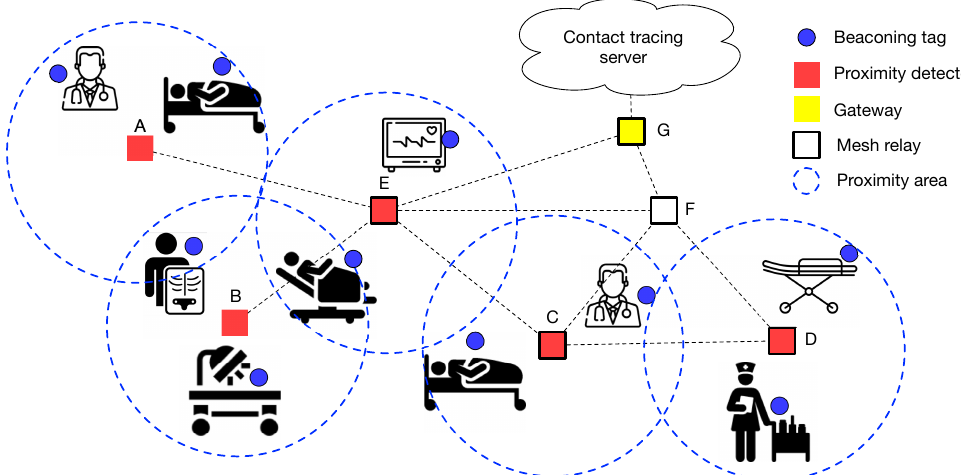
Figure 4. Bluetooth mesh infrastructure with the example topology. Beacons are identified with small colored circles. Nodes A and B are simple proximity detector, as they can read and process messages from beacons in their surrounding proximity area, which is limited by the dotted circles. Nodes C, D, and E behave as proximity detectors with respect to surrounding beacons, but also implement the relay feature of Bluetooth mesh to forward data received by the proximity detector and other mesh nodes in the network. Nodes F and G only serve as the relay node and the gateway, respectively, carrying traffic toward the contact tracing engine, but do not perform proximity